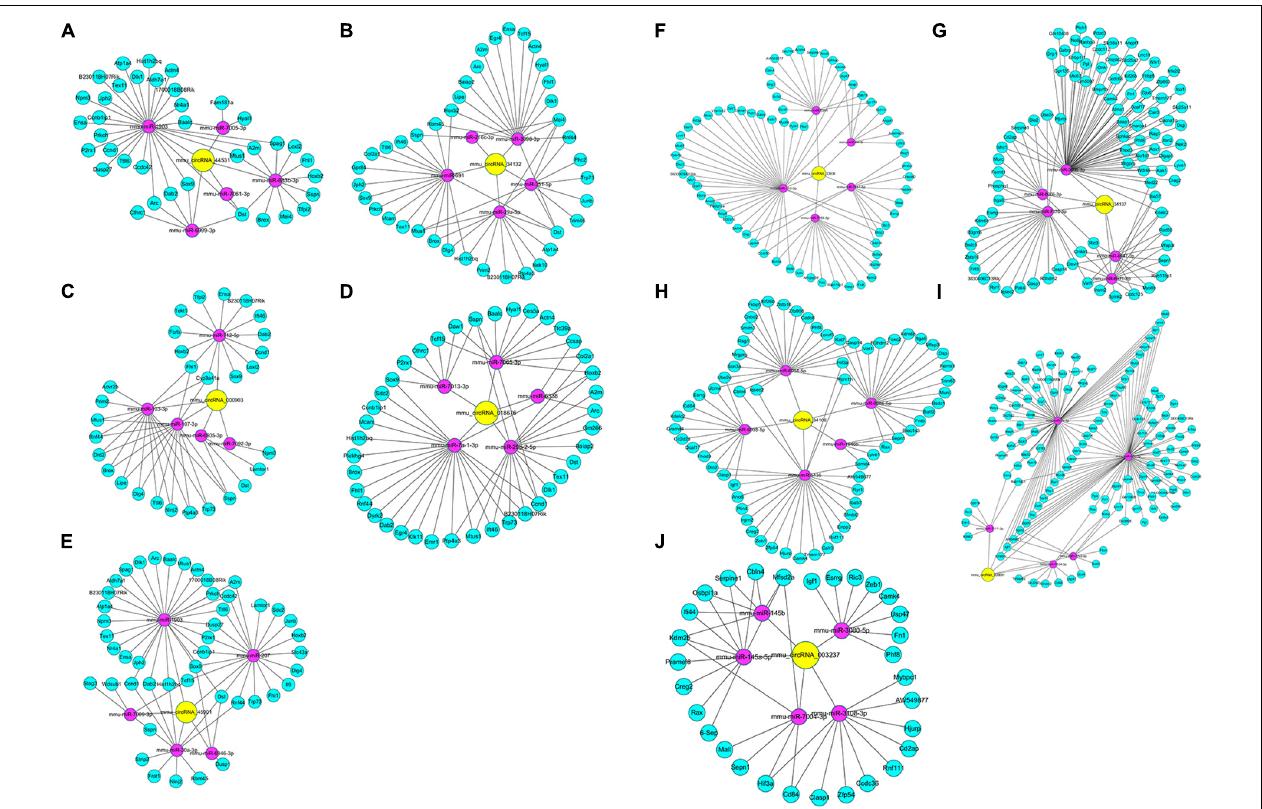
FIGURE 5 | DEcircRNA-miRNA-DEceRNA interaction subnetworks of up-regulated circRNAs and down-regulated circRNAs in the Nrf2 (–/–) hippocampus. (A) Subnetwork of mmu_circRNA_44531 in the Nrf2 (–/–) hippocampus. (B) Subnetwork of mmu_circRNA_34132 in the Nrf2 (–/–) hippocampus. (C) Subnetwork of mmu_circRNA_000903 in the Nrf2 (–/–) hippocampus. (D) Subnetwork of mmu_circRNA_018676 in the Nrf2 (–/–) hippocampus. (E) Subnetwork of mmu_circRNA_45901 in the Nrf2 (–/–) hippocampus. (F) Subnetwork of mmu_circRNA_33836 in the Nrf2 (–/–) hippocampus. (G) Subnetwork of mmu_circRNA_34137 in the Nrf2 (–/–) hippocampus. (H) Subnetwork of mmu_circRNA_34106 in the Nrf2 (–/–) hippocampus. (I) Subnetwork of mmu_circRNA_008691 in the Nrf2 (–/–) hippocampus. (J) Subnetwork of mmu_circRNA_003237 in the Nrf2 (–/–) hippocampus. Yellow nodes indicate DEcircRNAs. Magenta and green nodes indicate miRNAs sponged by DEcircRNAs and the gene ID of their DEceRNAs, respectively. Edges represent interactions.